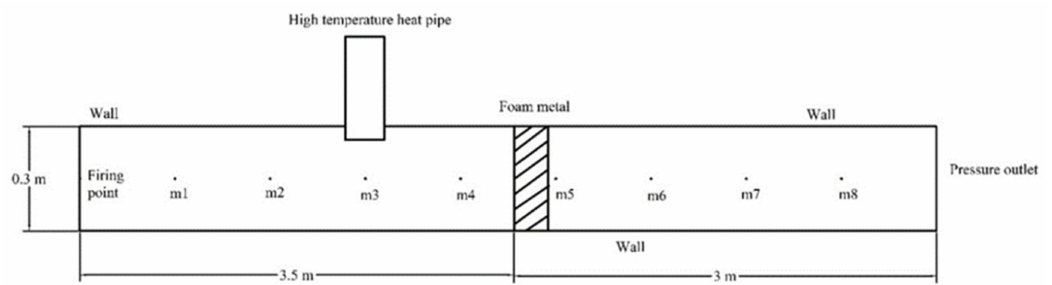
Figure 1. Physical